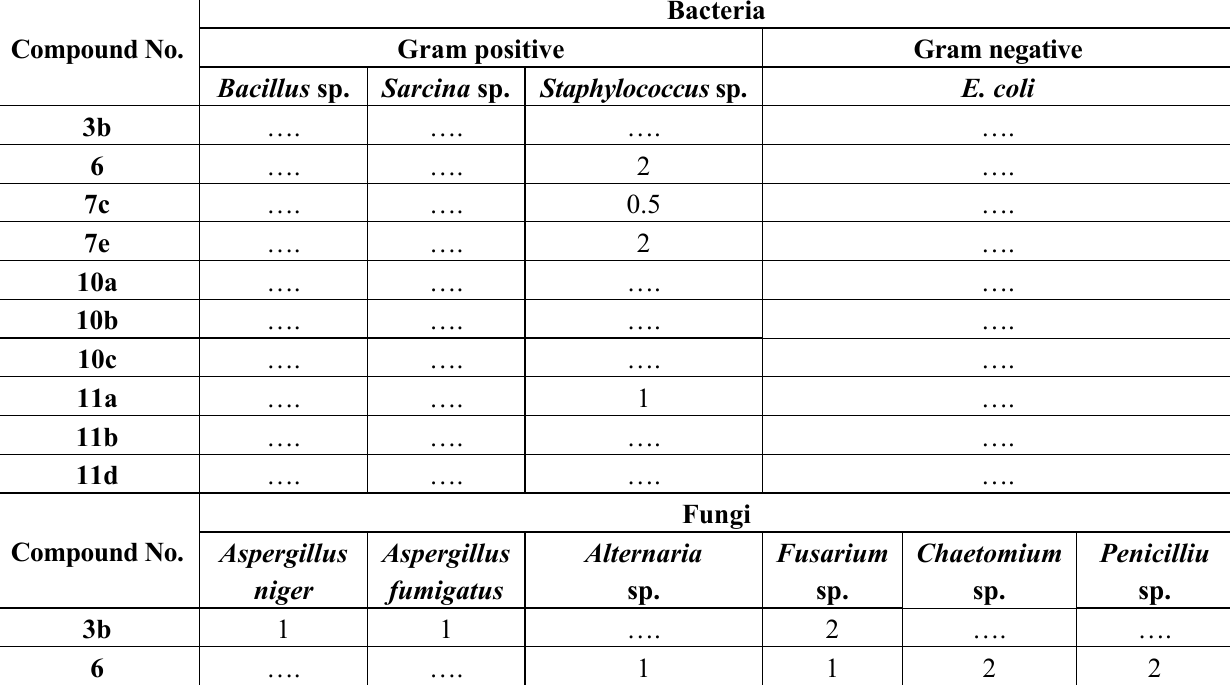
Table 2. Inhibition zones of tested compounds against selected microorganisms (mm). Compound